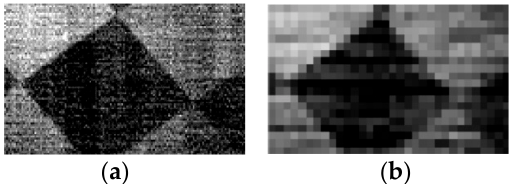
Figure 13. Oblique square images acquired by the SWIR AOTF imaging spectrometer on the basis of SPI. ( a ) High ‐ resolution image, ( b ) low ‐ resolution image.